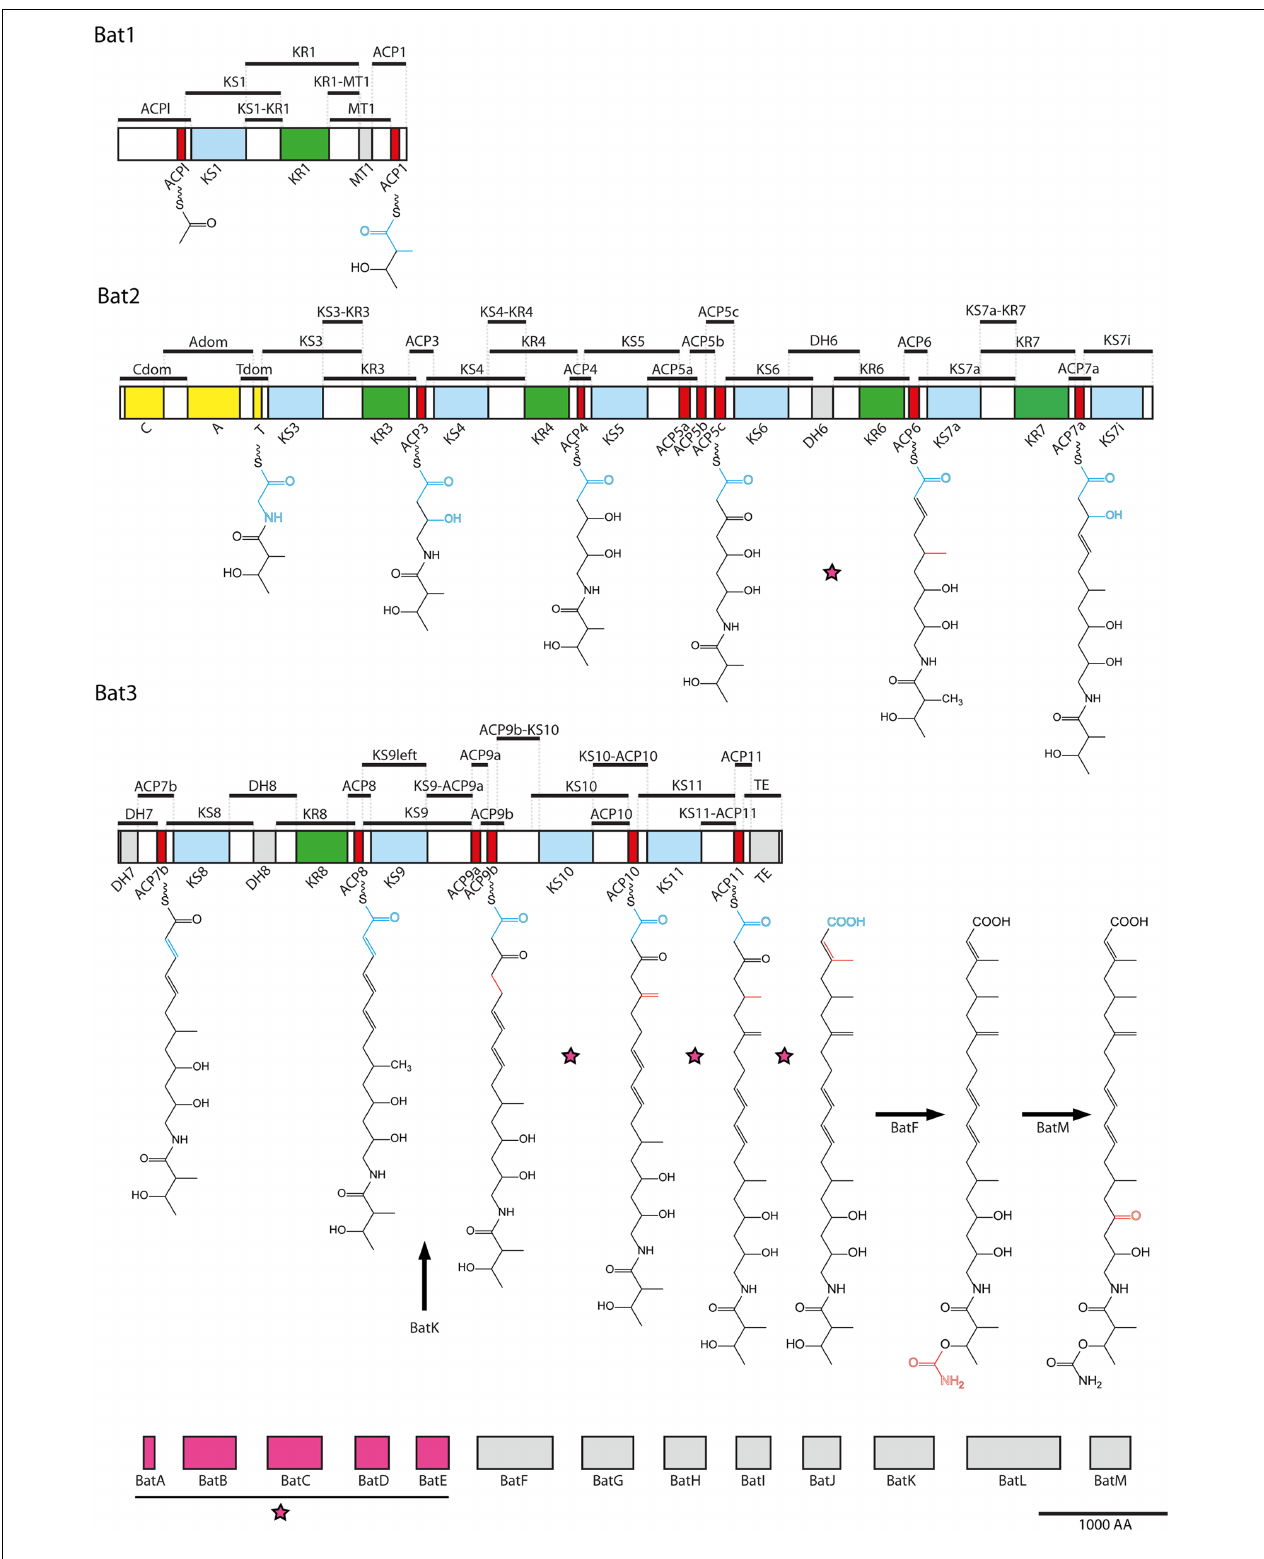
FIGURE 1 | Overview of fragmentation in the kalimantacin biosynthesis cluster. Kalimantacin biosynthesis is achieved by PKS and NRPS modules spread across three polypeptides, Bat1–Bat3, and supported by 13 modifying enzymes BatA-M. The NRPS module is colored yellow, while the KS, ACP and KR